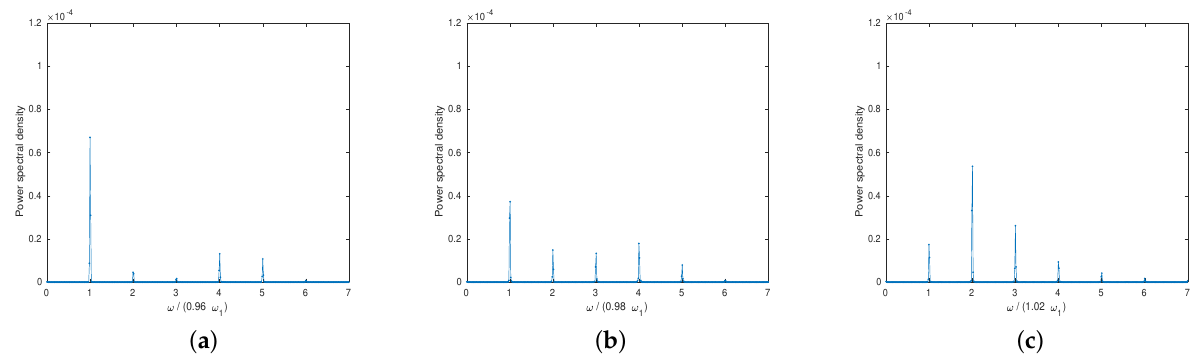
Figure 9. The frequency spectrum of pure roll cases under different excitation frequencies: ( a ) ω / ω 1 = 0.96; ( b ) ω / ω 1 = 0.98; ( c ) ω / ω 1 =